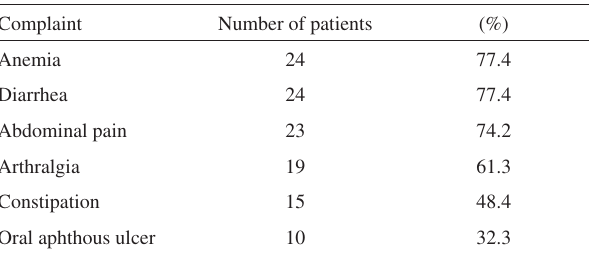
Table 2 - Complaints of patients with celiac disease, prior to diagnosis